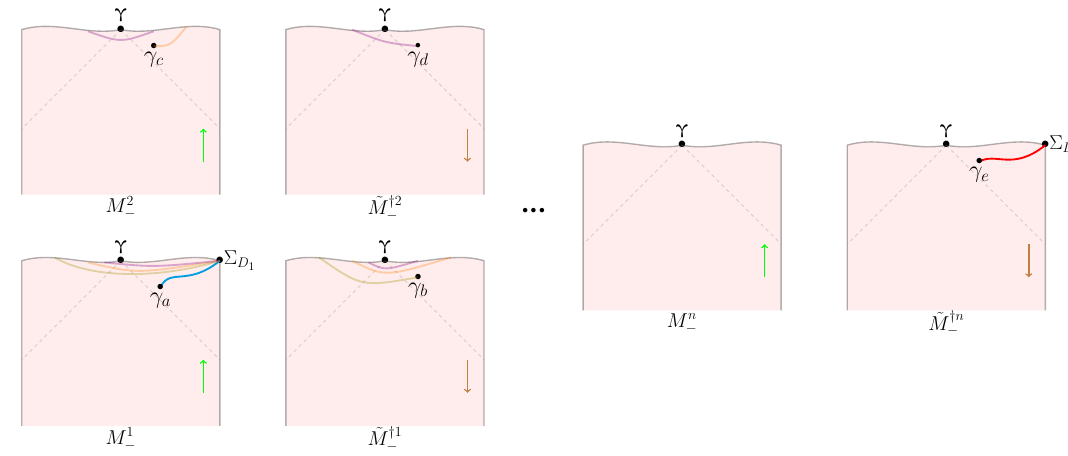
Figure 5 . After choosing a particular replica D 1 of D and an associated Cauchy surface Σ D one can find an achronal surface Σ γ from some codimension-2 surface γ to Σ D the domain of dependence of Σ or Σ , but not in the domain of dependence of Σ ˜ M † n M 1 ,R ,R − − for i 6 = 1 or Σ for j 6 = n . The blue and red surfaces are such Σ γ in the successful cases. ˜ M † j ,R − We also show typical surfaces (orange, brown, and magenta) that would connect other regions to Σ D . These latter surfaces must pass through regions with complex metric where achronality is not defined. Here the M i , ˜ M † j are sewn together as in figure 2. Thus, for example, the orange surface − − can be traced from γ c ⊂ M 2 across the seam at the upper right of this sheet into M † 1 − sheet moving to the left through the complex region to the past of g , across the seam at the upper left of M † 1 into M 1 , and finally across M 1 moving to the right through the complex region to the − − − past of g to reach Σ D